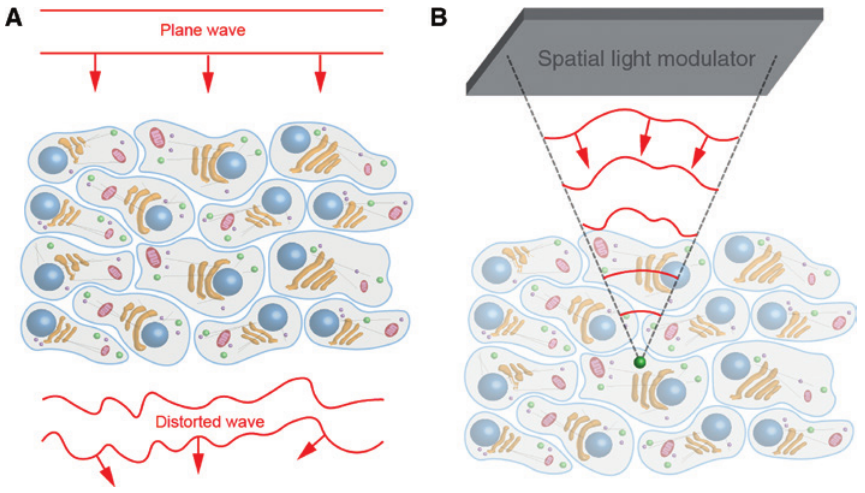
Figure 3: Scattering in tissue. (A) Illustration of light distortion through biological tissue. (B) Illustration of light wavefront shaping with an SLM aiming to optically manipulate an organelle within biological